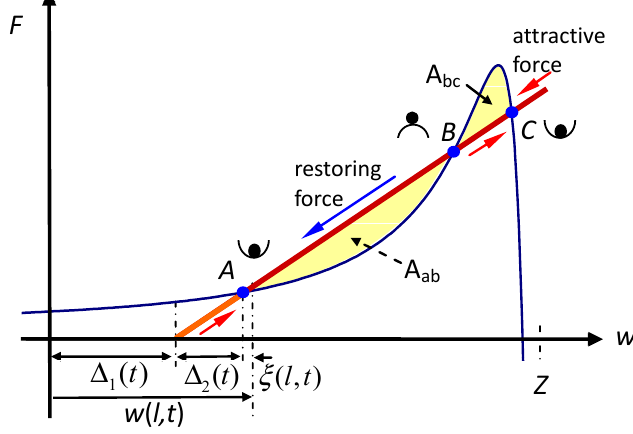
Figure 3. Schematics of the three equilibrium points for soft stiffness